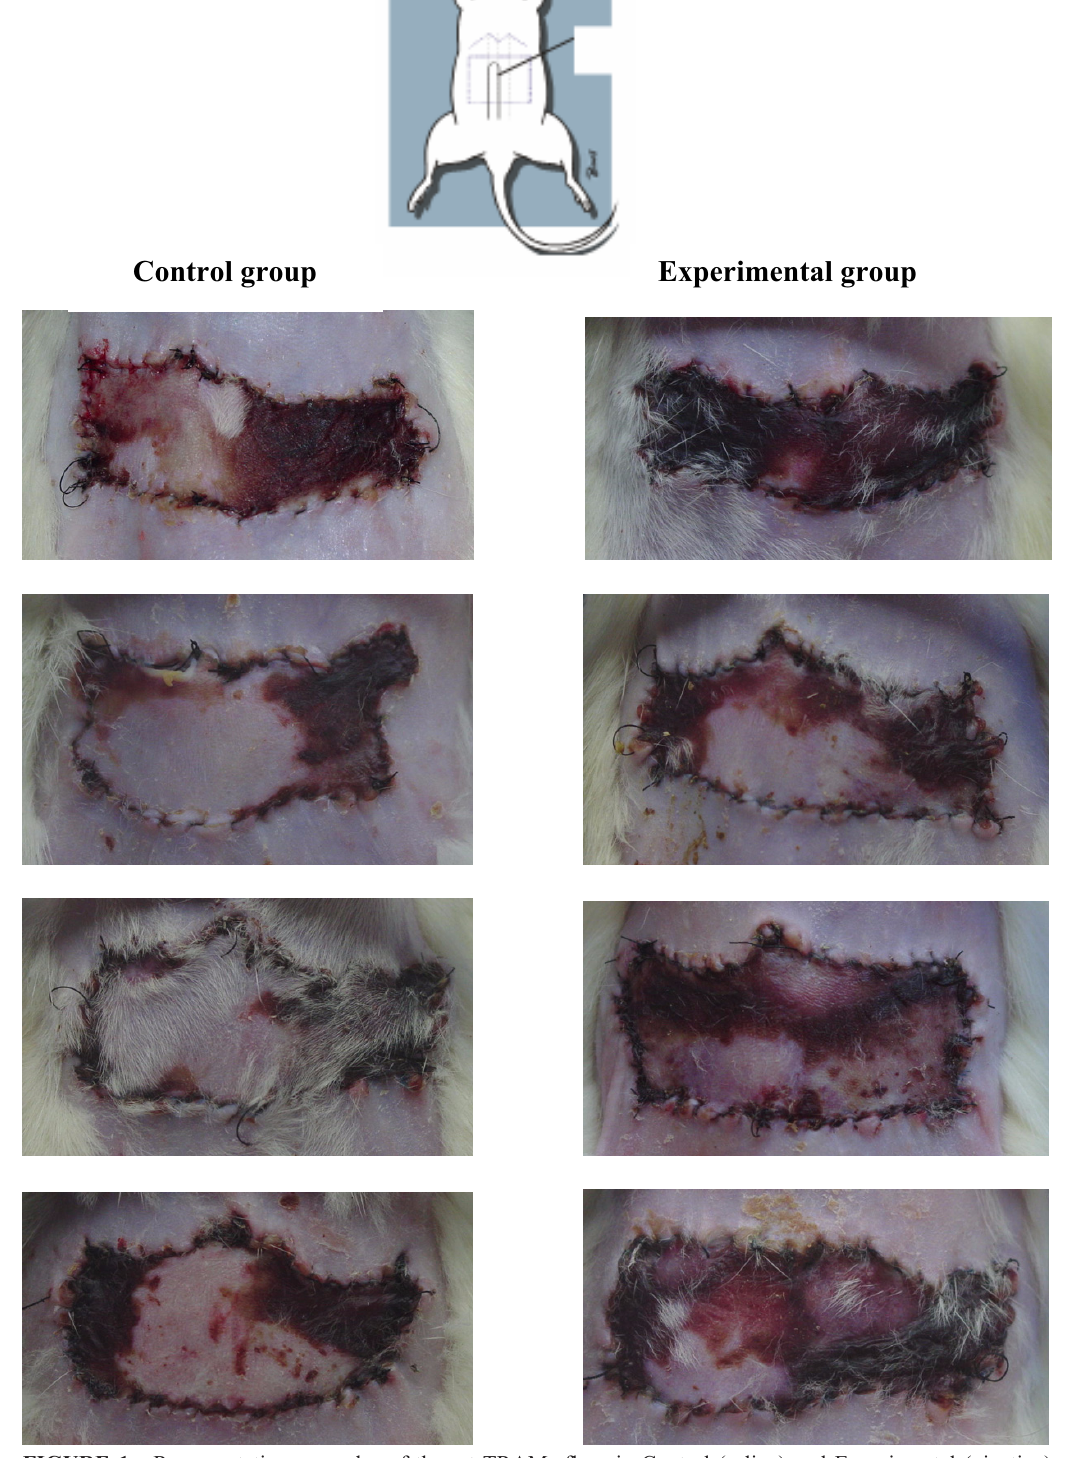
FIGURE 1 - Representative examples of the rat TRAM flap in Control (saline) and Experimental (nicotine) groups, showing the area of necrosis on the respective